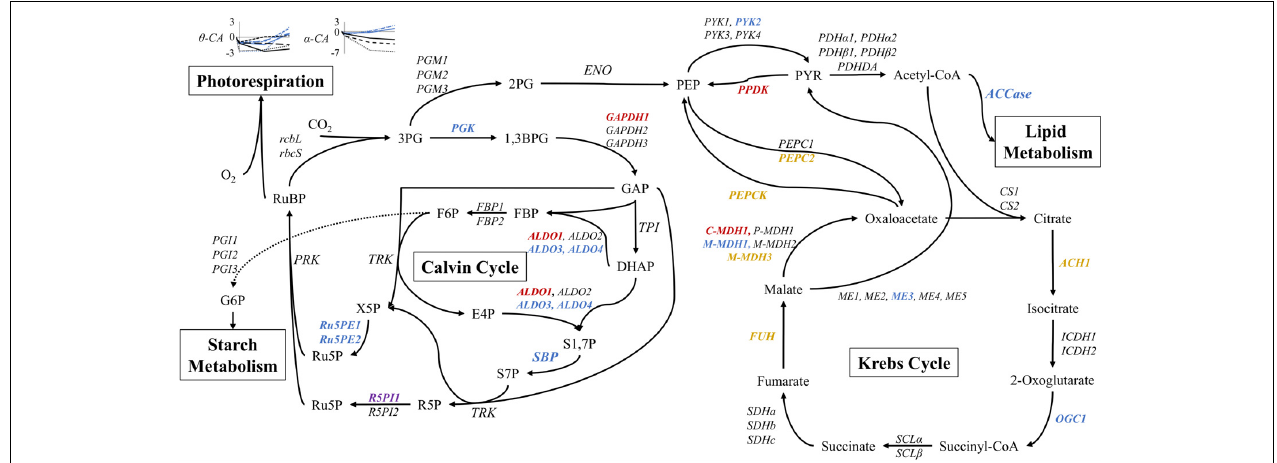
FIGURE 6 | Expression of core carbon metabolism genes under nitrogen starvation at 51 h. Metabolites are displayed between pathway arrows. Enzymes are italicized and colored according to the log 2 FC value of STAR over NO3 at 51 h. Red represents log 2 FC of greater than 2, orange is 1 to 2, black is no significant change, blue is –1 to –2, and purple is less than –2. Expression of θ and α carbonic anhydrase (CA) genes are shown over time in the nitrogen starvation (black) and nitrate (blue) conditions. Each line pattern represents a different CA gene. All points are represented as log 2 FC values in comparison to the inoculum culture. Expression data and transcript identities are in Supplementary Data Sheet 1 . Metabolite abbreviations are as follows: 3PG, 3-phosphoglycerate; 1,3BPG, 1,3-bisphosphoglycerate; GAP, glyceraldehyde 3-phosphate; DHAP, dihydroxyacetone phosphate; FBP, fructose 1,6-bisphosphate; F6P, fructose 6-phosphate;